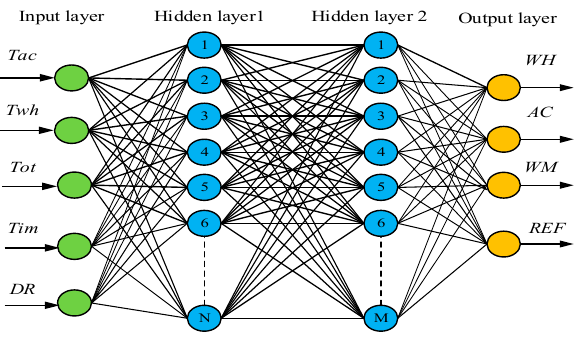
Figure 13. Architecture of the artificial neural network (ANN) algorithm.